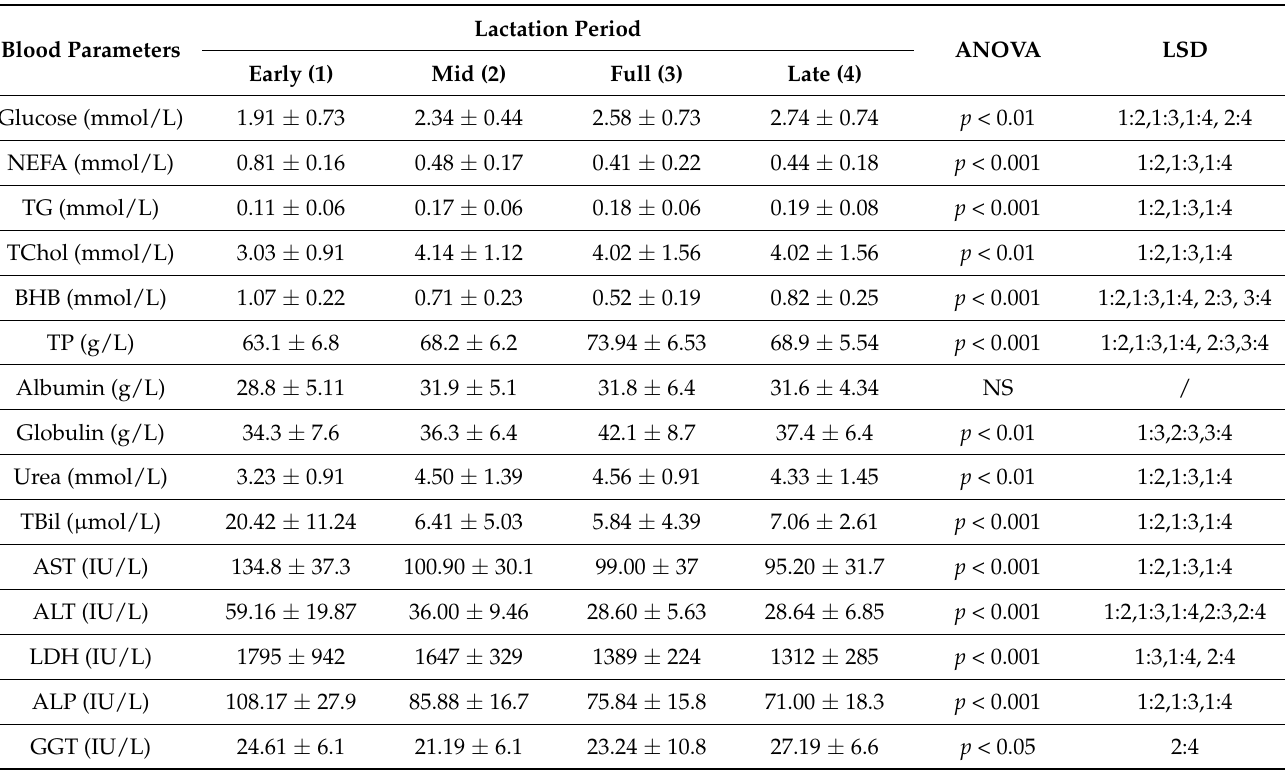
Table 1. Blood metabolic parameter in early (Group 1), mid (Group 2), full (Group 3) and late (Group 4) lactation dairy cows.